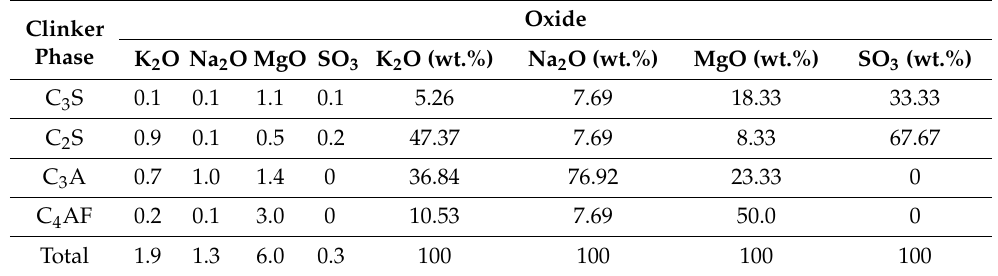
Table 4. Composition and percentages of oxides dissolved in cement clinker phases [20].